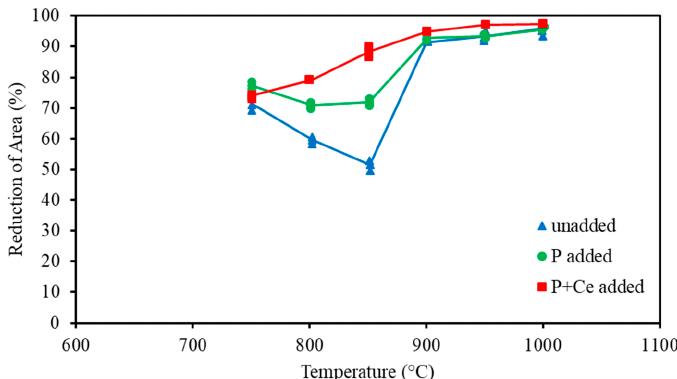
Figure 16. Hot ductility curves for low C, low Mn, 3% Ni, 1.75% Cr, 0.5% Mo material, having: no additions of P and Ce, a 0.045% P addition, and a 0.045% P, 0.03% Ce addition [90].